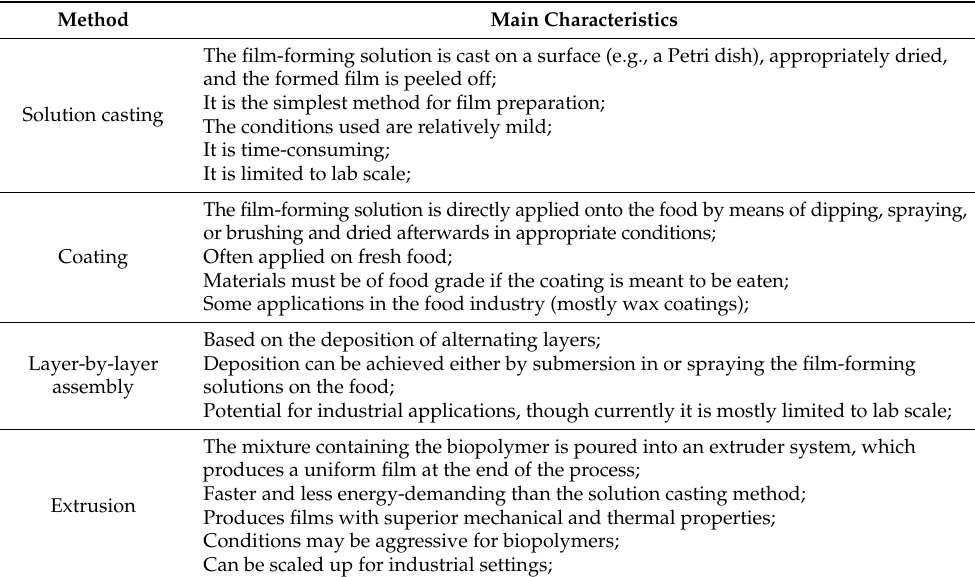
Table 1. Main methods for preparation of biopolymer-based films (Kumar et al., 2020; Wang et al.,